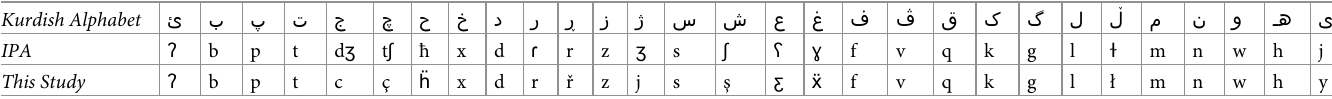
Table 1. Consonants of Standard Central Kurdish.